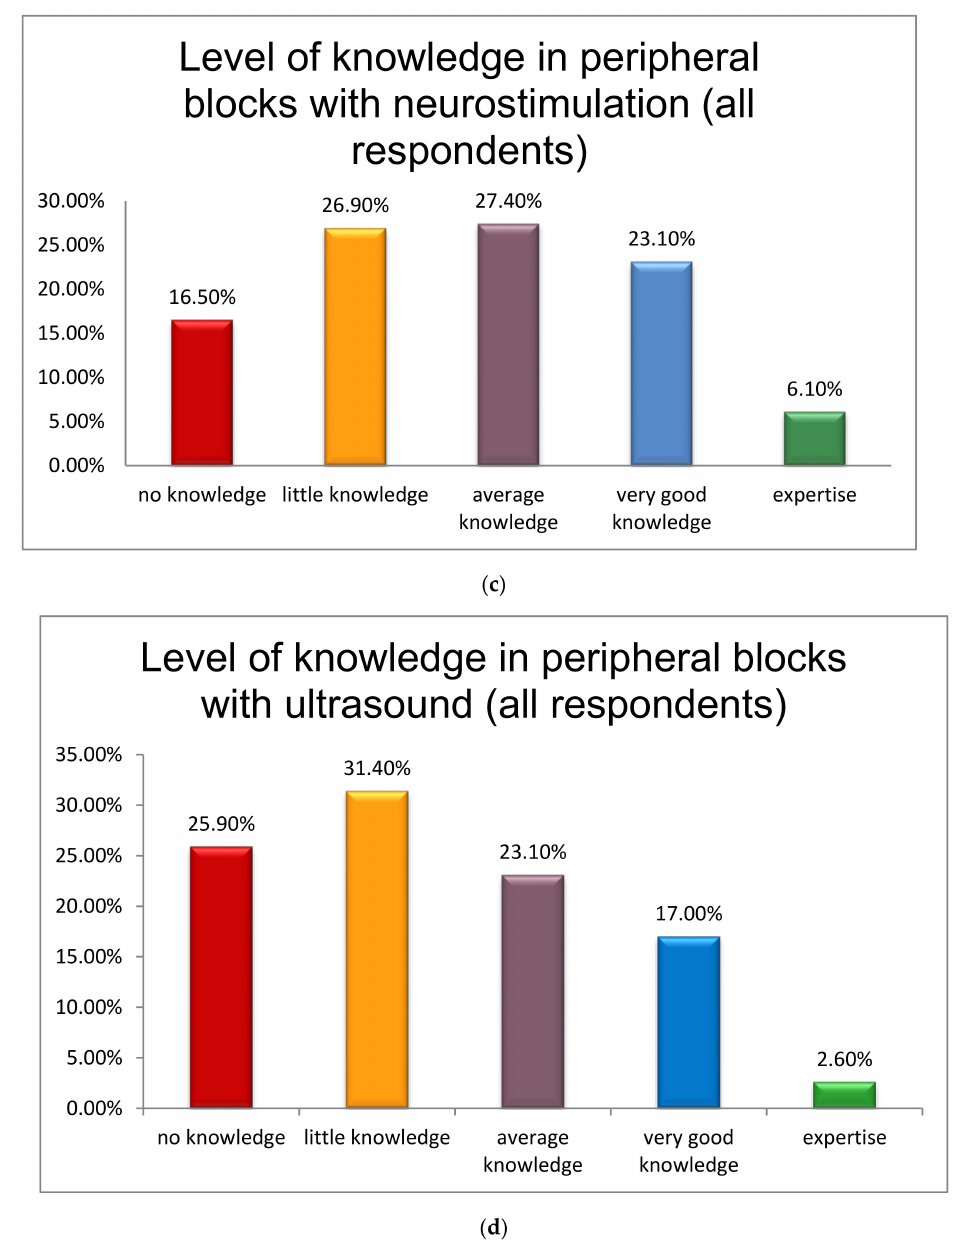
Figure 1. ( a ) Level of knowledge in central blocks (all anesthesiologists who responded to the survey) ( b ) Level of knowledge in central blocks with ultrasound guidance (all anesthesiologists who responded to the survey) ( c ) Level of knowledge in peripheral blocks with neurostimulation (all anesthesiologists who responded to the survey) ( d ) Level of knowledge in peripheral blocks with ultrasound guidance (all anesthesiologists who responded to the